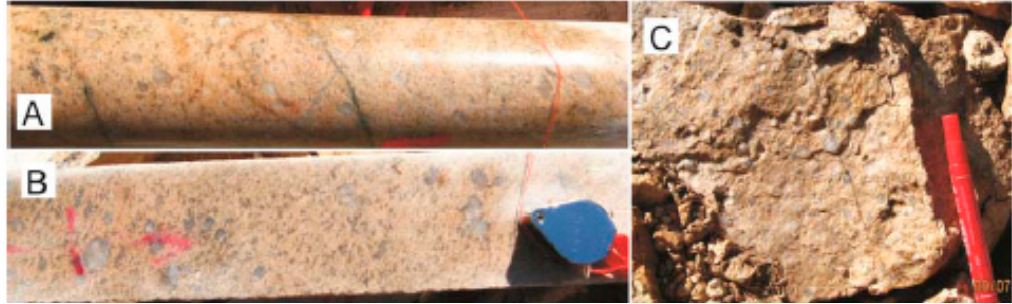
Figure 3. Characteristics of porphyritic granite in the Dongping gold deposit. ( A , B ) Porphyritic quartz in the porphyritic granite with chlorite veins, ZK301A drilling; ( C ) an outcrop of the porphyritic granite on the surface, Mazhangzi.